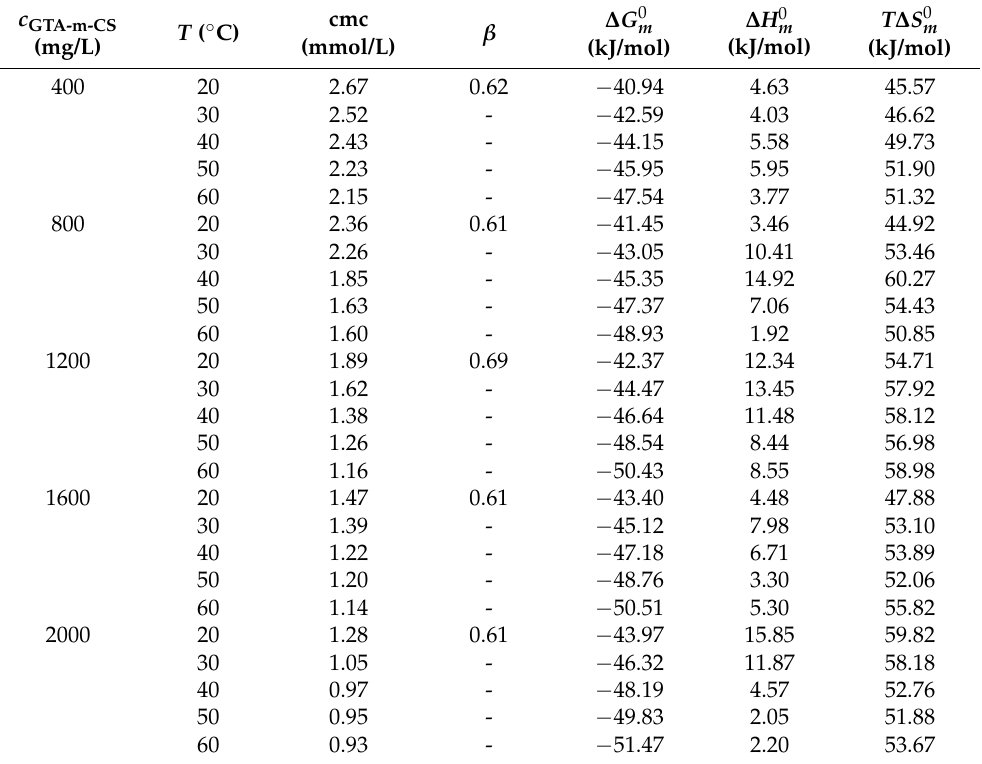
Figure 4. Plots of conductivity ( A ) and cmc ( B ) vs. concentration of DDEAC at different GTA-m-CS concentration and temperature. Table 3. Parameters of GTA-m-CS/DDEAC Systems with Different Concentration of GTA-m-CS and Temperature Obtained from Conductivity